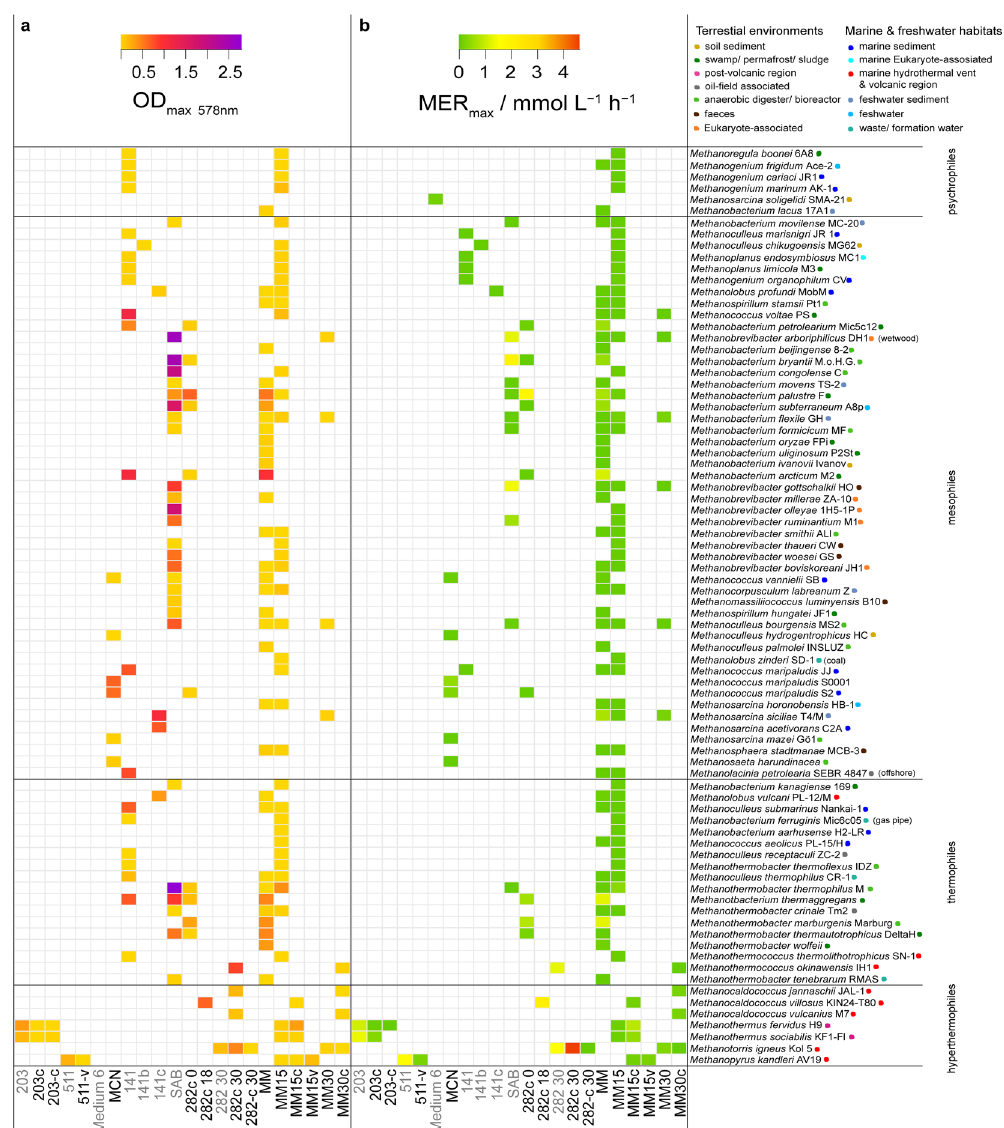
Fig. 1 Biomass and CH 4 production kinetics of the multivariate prescreen of 80 methanogens in de fi ned and complex media. Experiments were performed in closed batch cultivation systems at 2 bar (120 mL fl asks, 50 mL medium). On the y -axis, methanogens were arranged as groups according to their temperature optimum in psychrophiles, mesophiles, thermophiles, or hyperthermophiles. Methanogens are listed with ascending strain-speci fi c temperature optimum from top to bottom. Coloured points next to the strain designation on the y -axis indicate the isolation site of the tested methanogen (terrestrial habitats: golden brown — soil sediment, dark green — swamp/permafrost/sludge, pink — post-volcanic region, gray — oil- fi eld associated, light green — anaerobic digester/bioreactor, brown — feces, orange — eukaryote-associated; marine and freshwater environments: bright blue — marine sediment, turquoise — marine eukaryote-associated, red — marine hydrothermal vent and volcanic region, gray blue — freshwater sediment, sky blue — freshwater, green blue — waste/formation water). In total, 22 de fi ned and complex media were tested, but not every strain was cultivated on every medium. De fi ned and complex media are shown on the x -axis in black and gray fonts, respectively. For each closed batch cultivation, three biological replicates (in some cases, two biological replicates) plus one negative control were used. a The maximum absorption is shown as OD max at 578 nm, and b the maximum volumetric CH 4 production rate is shown as MER max / mmolL − 1 h − 1